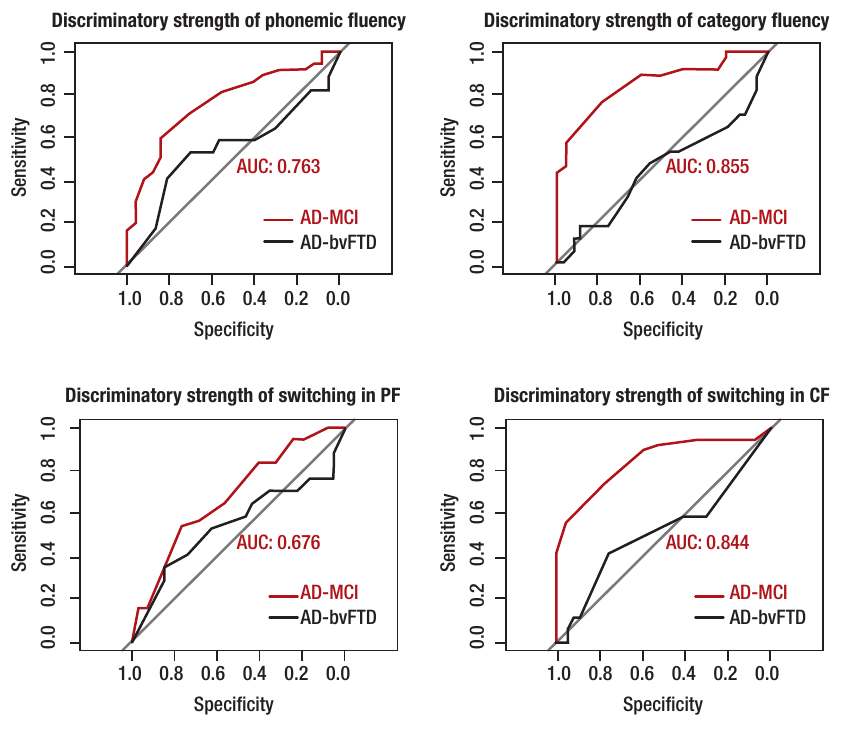
Figure 2. Discriminatory strength of switch- ing on phonemic and category fluency tasks. PF: phonemic fluency; CF: category fluency; AUC: area under the curve. Red curve indicates AD-MCI compari- son, black curve indicates AD-bvFTD comparison. AUC displayed for most-sensitive group difference, in both cases, AD vs.